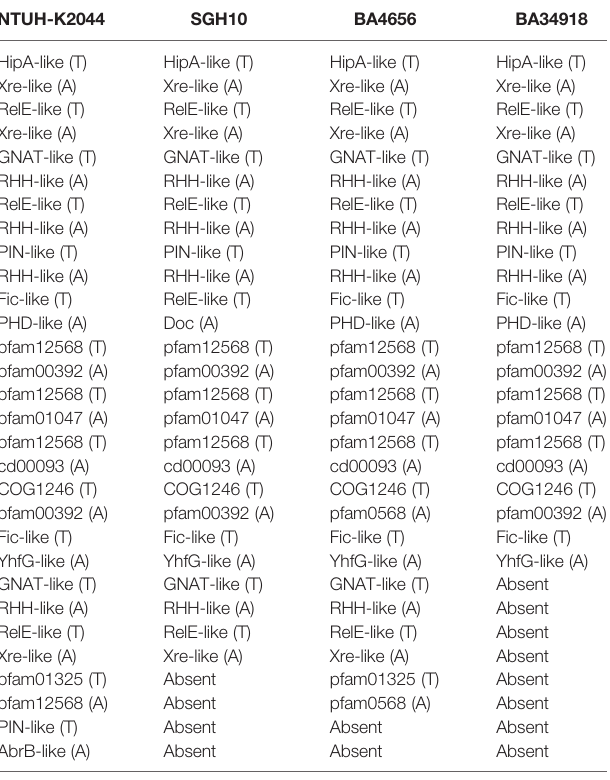
TABLE 2 | Chromosomal toxin and antitoxin systems encoded by Klebsiella pneumoniae